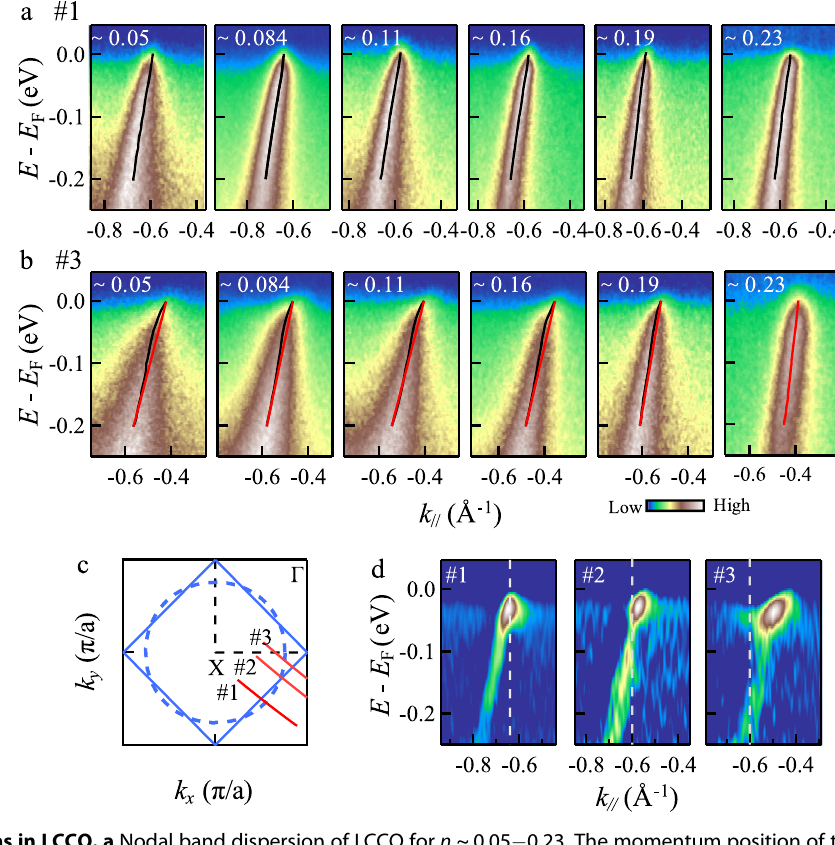
Fig. 1 Band dispersions in LCCO. a Nodal band dispersion of LCCO for n ~ 0.05 − 0.23. The momentum position of these bands is indicated as cut 1 in c . ARPES spectrum at the node of n ~ 0.084 was performed at 10 K. b Band dispersion near the antinode, represented as cut 3 in c . For n ~ 0.05 − 0.11, samples were ozone/vacuum annealed from as-grown fi lms with Ce concentration x = 0.1, and for n ~ 0.14 − 0.19, samples were annealed from one fi lm with x = 0.19. The band structures at n ~ 0.23 are from our previous work 21 . The black lines are the peaks of the MDCs extracted by Lorentzian fi tting, and the red lines are the assumed linear bare bands. c Schematic of the Fermi surface at n ~ 0.084. Cut 1, cut 2, and cut 3 indicate the momentum cuts along the nodal direction, the near hotspot, and the antinode. d Second derivative images of the band dispersions at n ~ 0.084 as marked in c . The white dashed lines indicate the antiferromagnetic zone boundary.